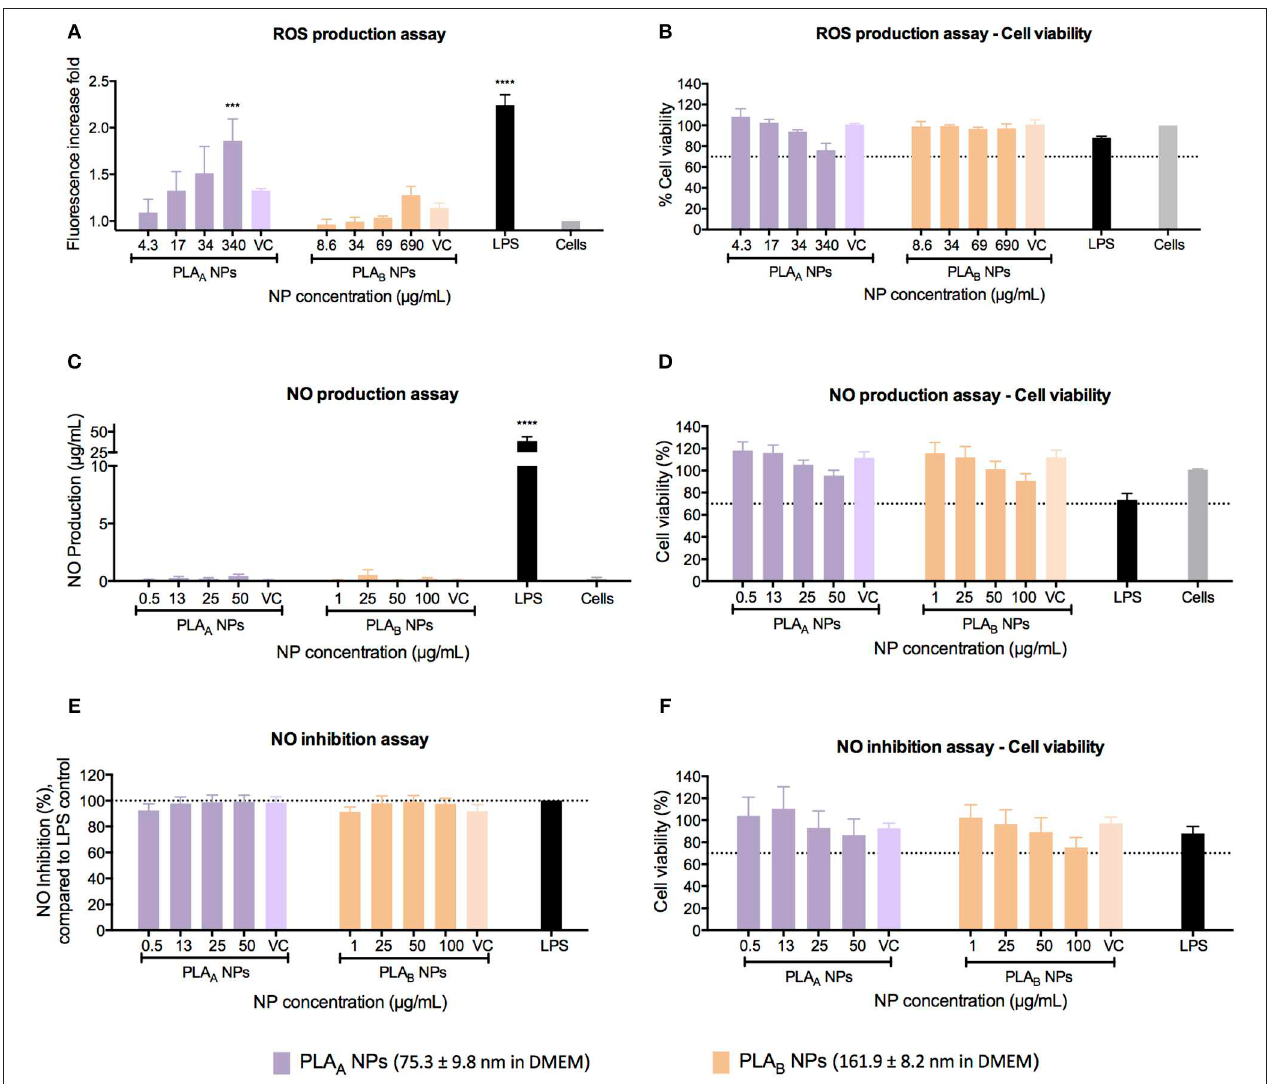
FIGURE 5 | Immunotoxicity assays, performed in RAW 264.7 macrophage cell line after 24h of incubation with PLA NPs and PLA NPs dispersion media (VC). (A) ROS production assay using LPS as a positive control and unstimulated cells as a negative control. Results are presented in fluorescence increase fold compared to the negative control. (B) Cell viability assay (MTT) after the performance of ROS production assay. (C) NO production assay using LPS as a positive control and unstimulated cells as a negative control. (D) Cell viability assay (MTT) after the performance of NO production assay. (E) NO inhibition assay. For the estimation of PLA NPs inhibitory effect on NO production, PLA NPs were incubated simultaneously with LPS. The percentage of NO inhibition was calculated considering 100% the NO production induced by LPS without PLA NPs (F) . Cell viability assay (MTT) after the performance of NO inhibition assay. Data are presented as mean ± SEM, n ≥ 3 (three or more independent experiments, each in triplicate). *** p < 0.001 and **** p <